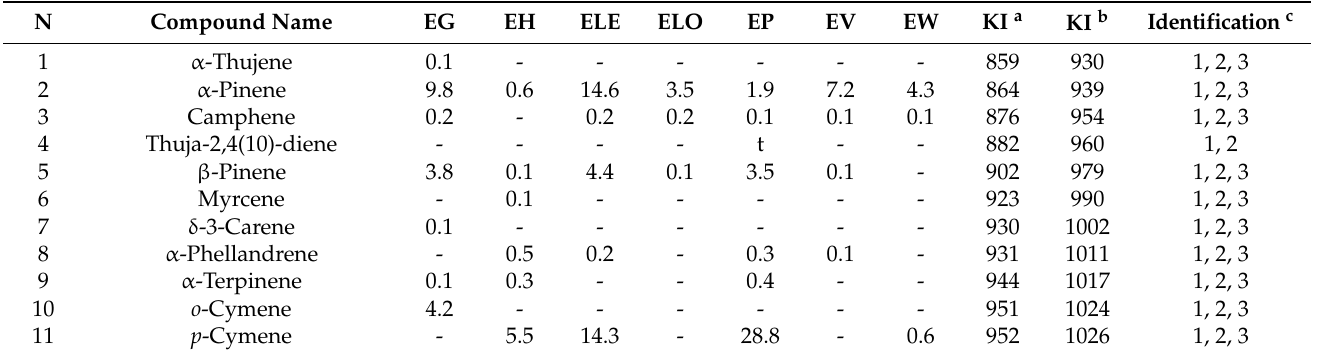
Table 2. Chemical composition of the EOs [ E. griffithsii (EG), E. hemiphloia (EH), E. lesoufii (ELE), E. longicornis (ELO), E. pyriformis (EP), E. viminalis (EV), E. wandoo